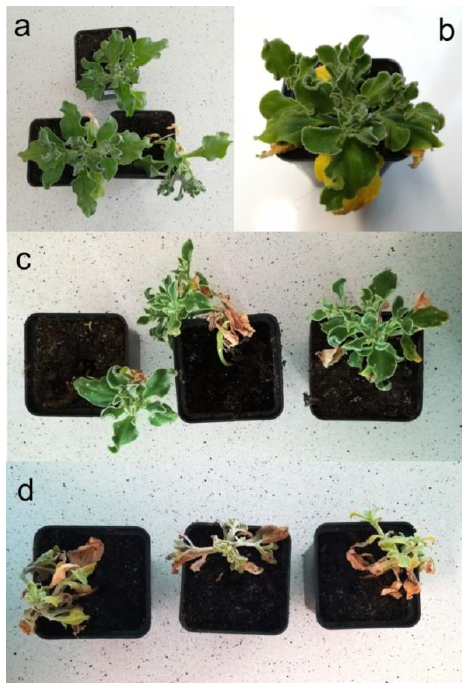
Figure 1. Morphological evaluation of toxicity symptoms caused by treatment of the common ice plant ( M. crystallinum ) with cadmium chloride ( b ) and potassium chromate ( c , d ). ( a ) control plants; ( b ) Cd treatment (800 µmol per pot = 818 mg kg -1 soil d.w., initial toxicity symptoms upon 8-day incubation); ( c ) chromate (3.6 mmol per pot = 1699 mg kg −1 soil d.w., initial toxicity symptoms upon